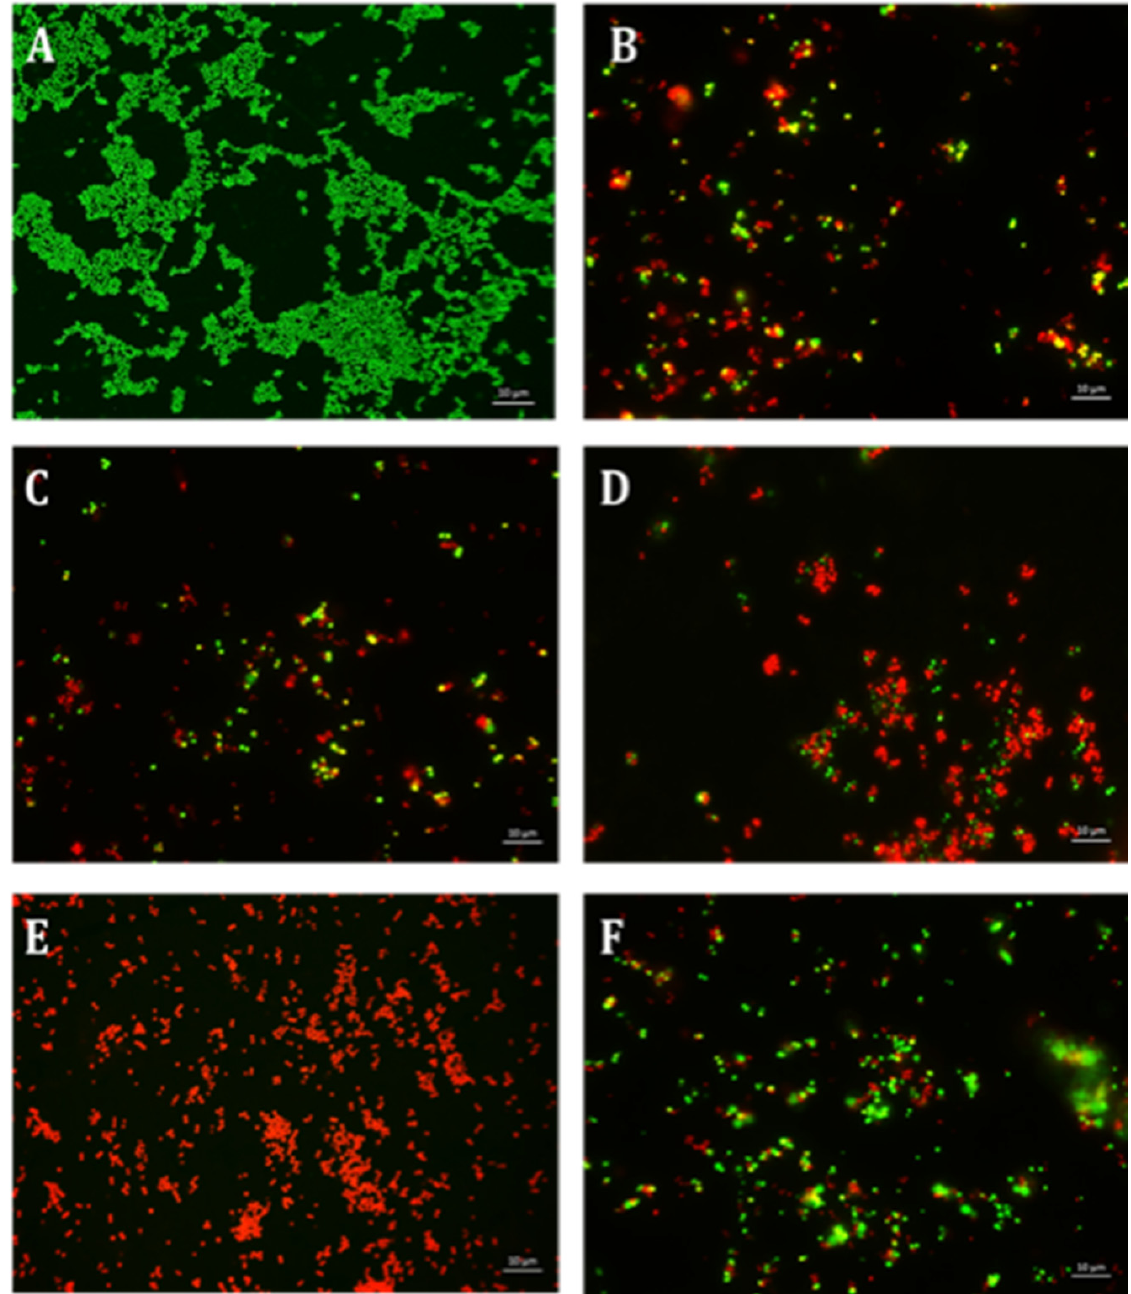
Figure 10. Fluorescence microscopic observation of cell viability on S. epidermidis biofilm formation. TE: tetracycline; ES: EGCG-S. Scale bar = 10 µ m. ( A ) Control, ( B ) TE15, ( C ) ES100, ( D ) TE15+ES200, ( E ) TE15+ES250, and ( F ) TE30+ES100. The results indicated that TE15+ES250 severely affect the viability of the